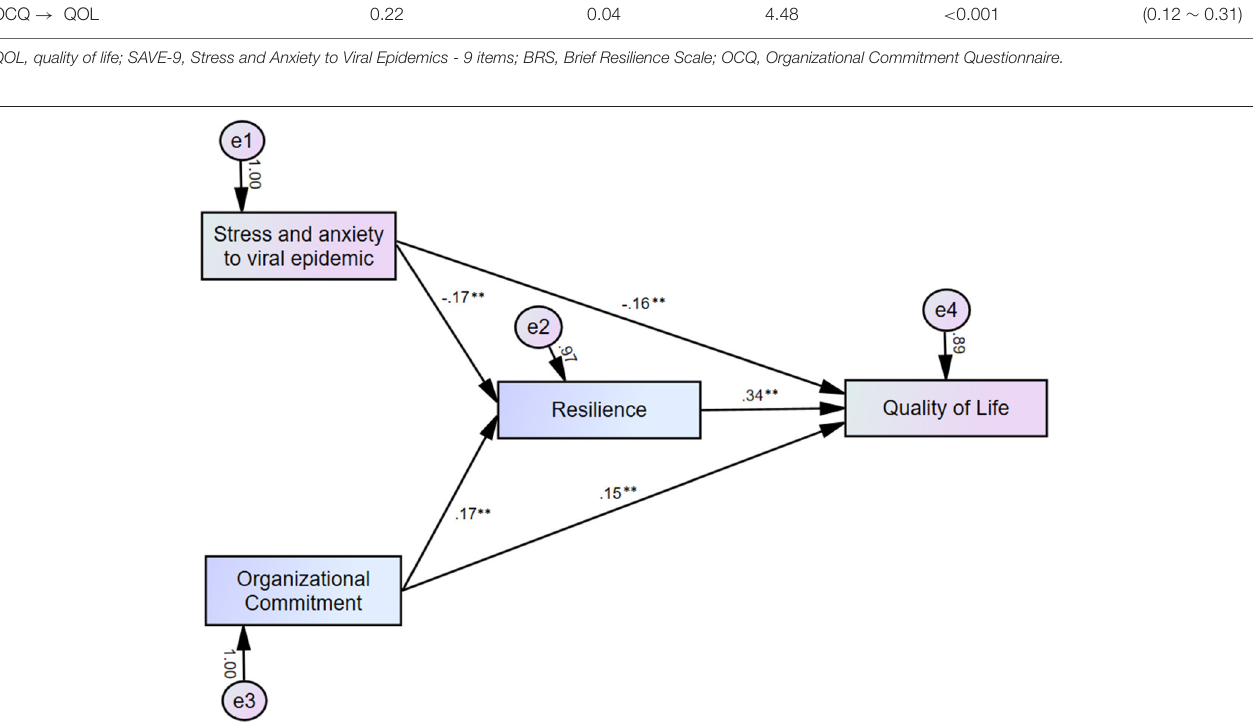
high level of resilience, and high organizational